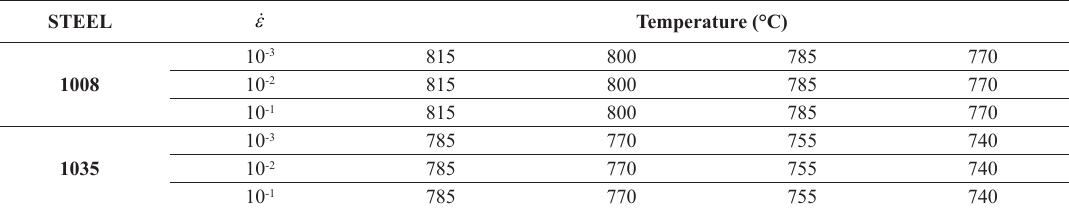
Table 3. Experimental conditions.